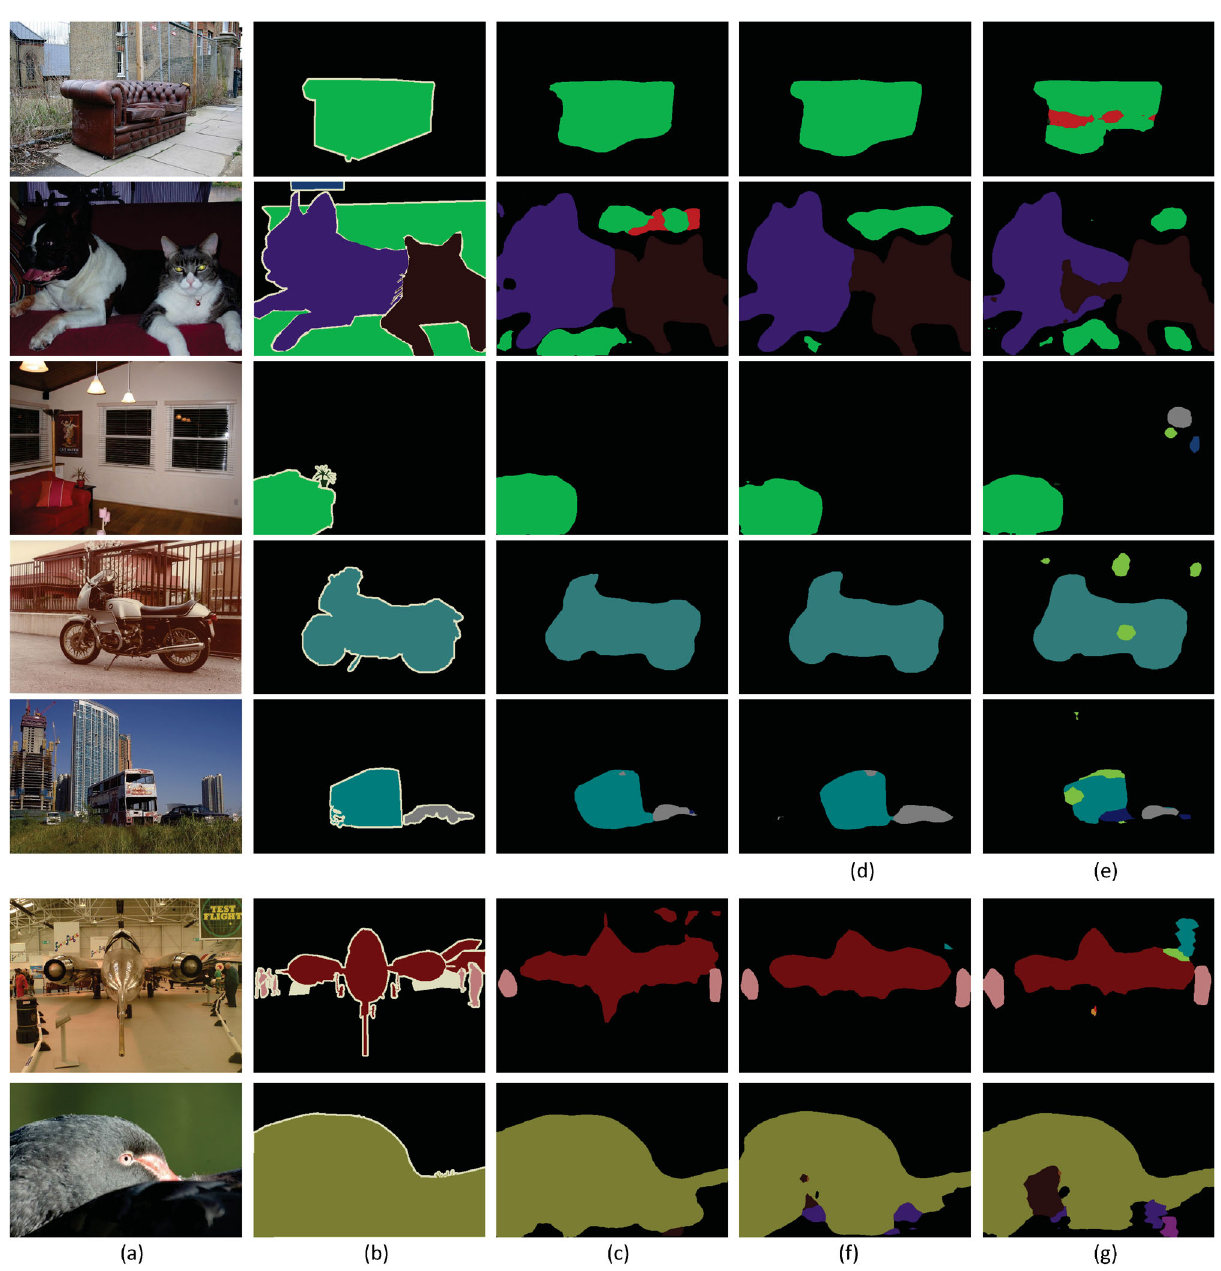
Fig. 3 General image parsing results on the PASCAL VOC 2012 validation set. (a) Original images. (b) Ground truth. (c) Baseline model with dilation value of 12 and best manually selected receptive field. (d) Modified model with initial dilation value of 20. (e) Baseline model with dilation value of 20. (f) Modified model with initial dilation value of 4. (g) Baseline model with dilation value of 4. Results in (d) and (e), (f) and (g) show the improvements brought by our method. With finer receptive fields, results from the modified model are generally more consistent. Results in (d) have clearer shapes and boundaries than results in (e). Results in (c), (f), and (g) show that with poor initial receptive fields, modified models are still improved but not as good as the best manually designed models. Results in (c) and (d) show that, if the initial receptive field is properly set, our model has comparable performance to the manually designed model: our method can replace previous receptive field design